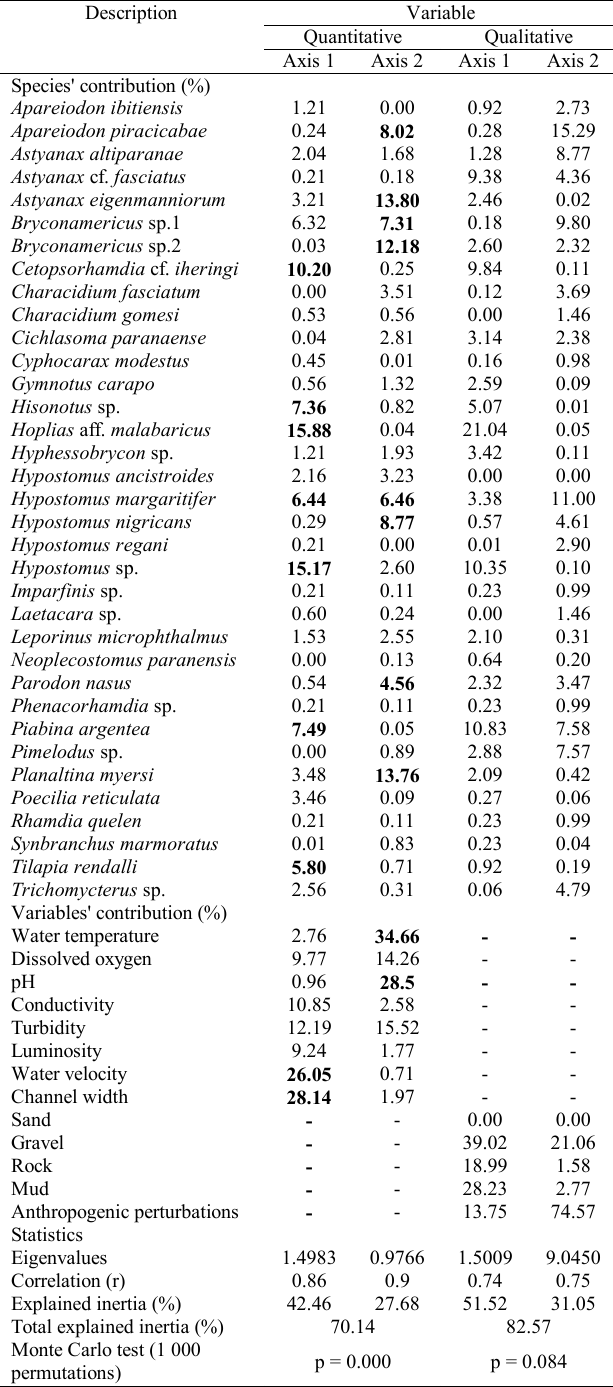
Table 4 . Fish species, quantitative and qualitative variables contribution (%) to axes and statistics of the co-inertia analysis. Boldface values indicate major